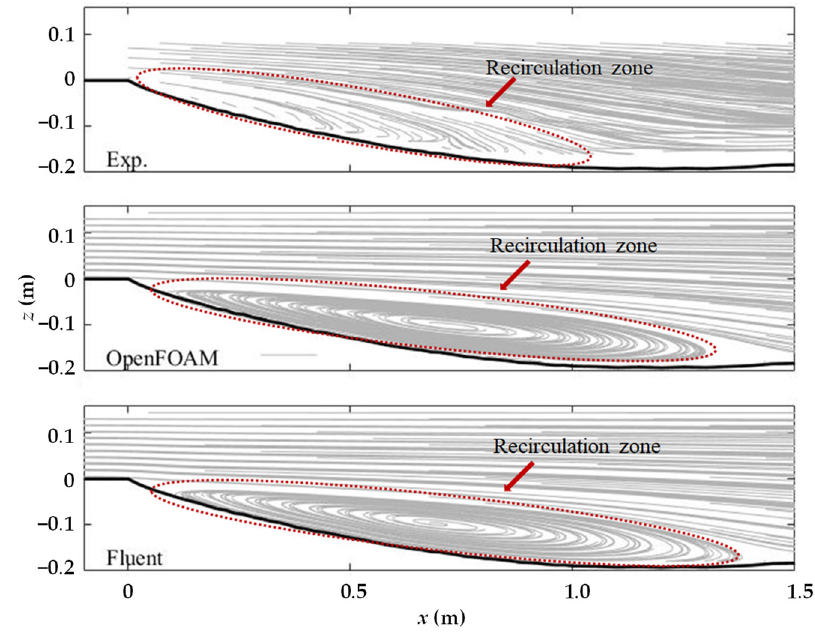
Figure 5. Numerical results of streamline by OpenFOAM and Ansys Fluent models in comparison with laboratory experimental data. The thick black lines present scoured channel beds.